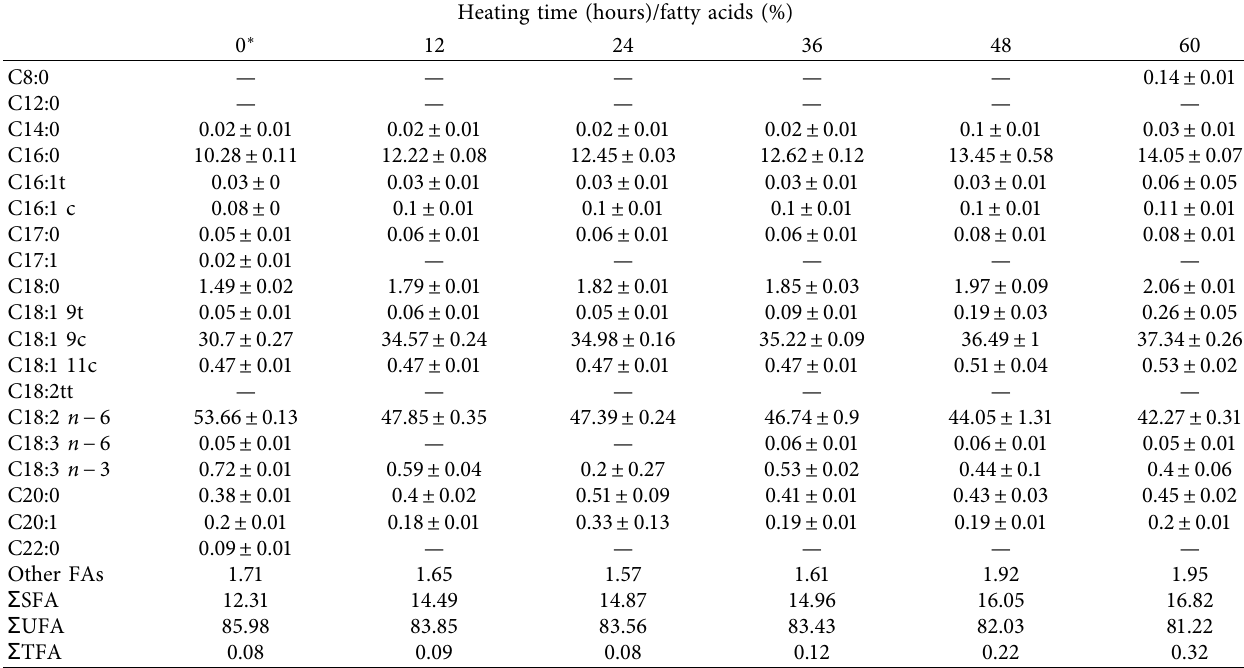
Table 10: Variation of fatty acids of corn oil under 210 ° C heating temperature at different heating